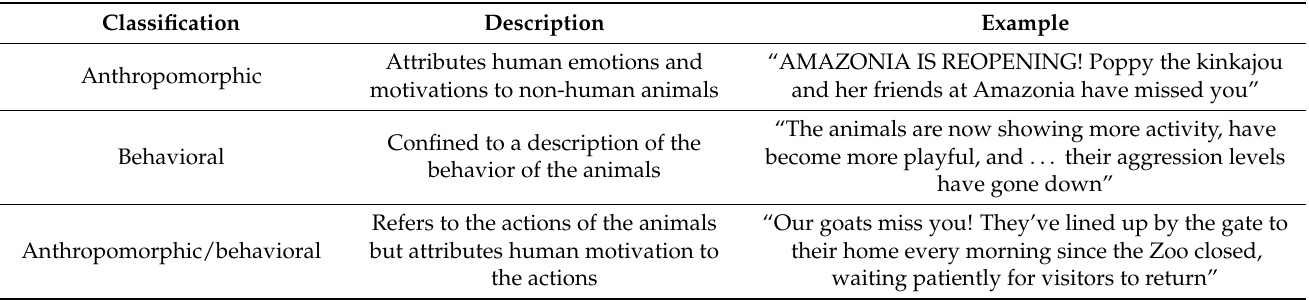
Table 2. Classification of Facebook posts and news reports, with reference to their anthropomorphic description, behavioral description, or a combination of